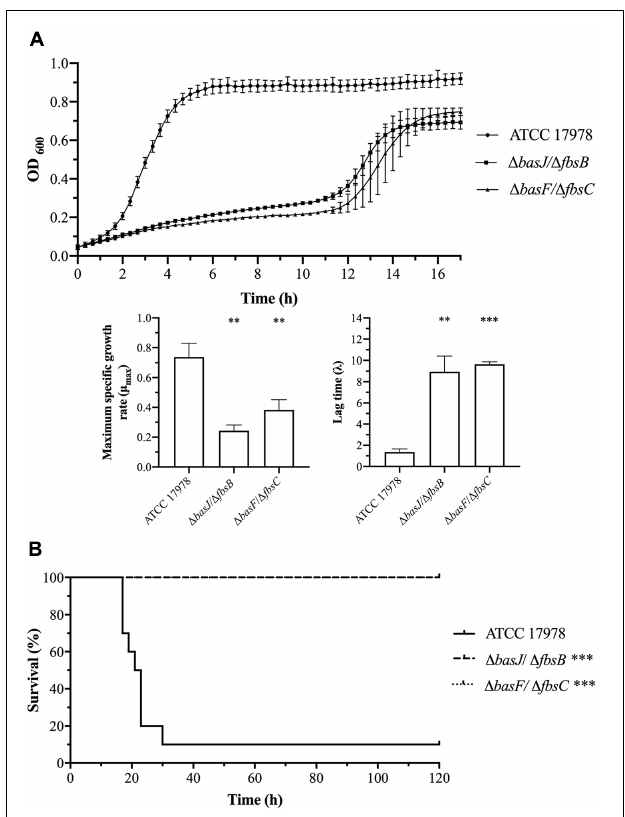
FIGURE 6 | (A) Growth curves and growth kinetics of A. baumannii ATCC 17978 and the (cid:49) basJ/ (cid:49) fbsB and (cid:49) basF/ (cid:49) fbsC double mutant strains. The growth curves were performed under iron-limiting conditions. (B) Sepsis infection in mice. Survival of BALB/c mice ( n = 10 per group) after bacteremia infection with A. baumannii ATCC 17978 and the (cid:49) basJ/ (cid:49) fbsB and (cid:49) basF/ (cid:49) fbsC double mutant strains. The log-rank (Mantel-Cox) test was used for statistical analysis ( ∗∗ P < 0.01, ∗∗∗ P <